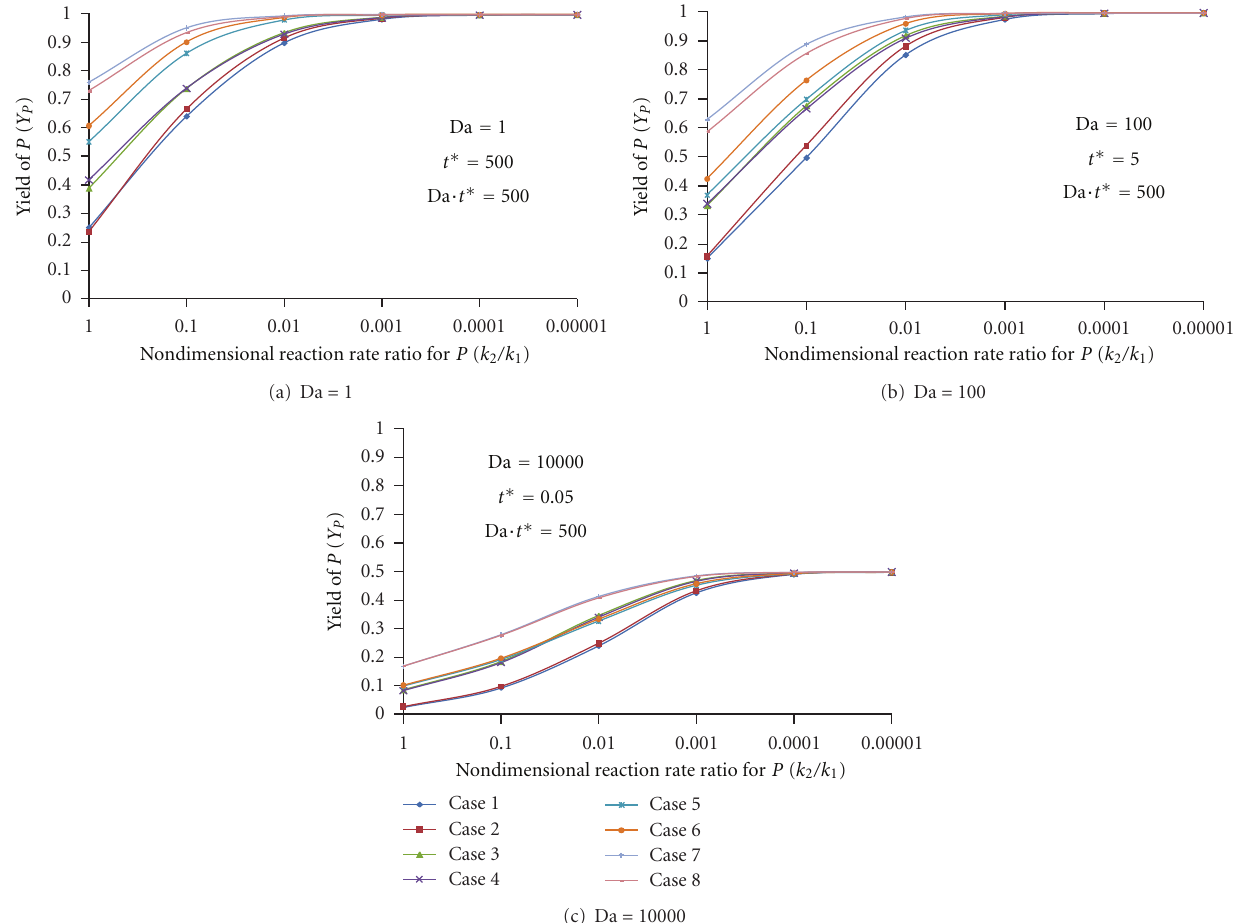
Figure 4: Plots of yield of P versus k 2 / k 1 for various Da at Da · t ∗ = 500 for C-C